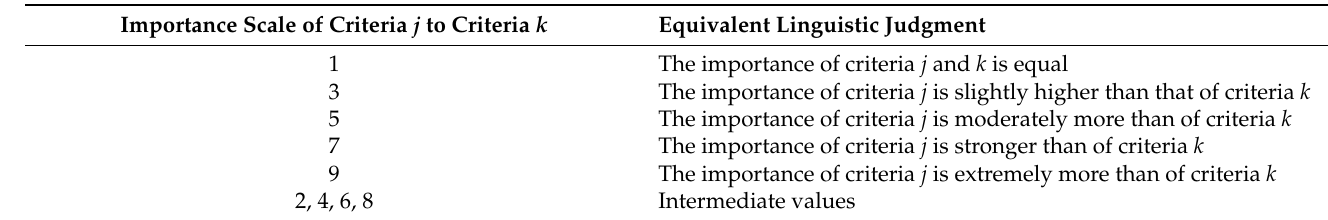
Table 2. Pairwise comparisons on a relative scale.